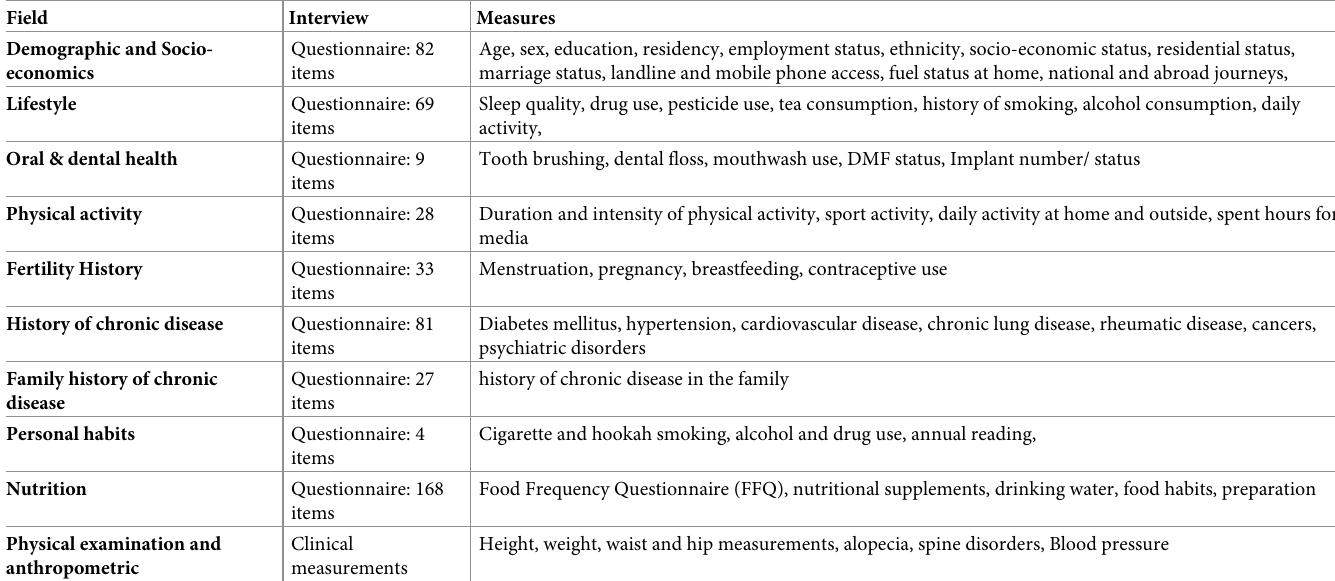
Table 2. Measures and tools administered at the enrollment